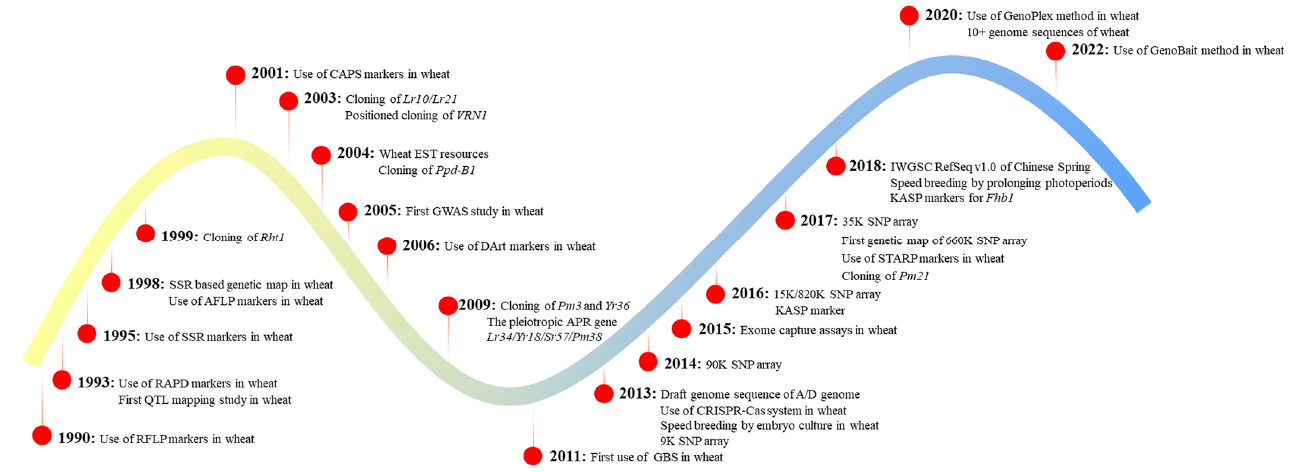
Figure 1. Timeline of application of molecular markers in wheat breeding and research.